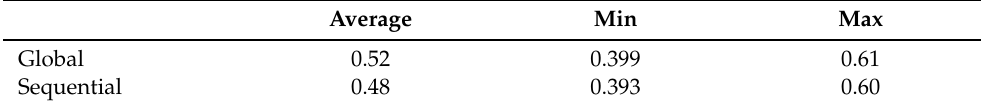
Table 5. Statistics of the weights in similarity aggregation for the global and sequential embedding spaces.